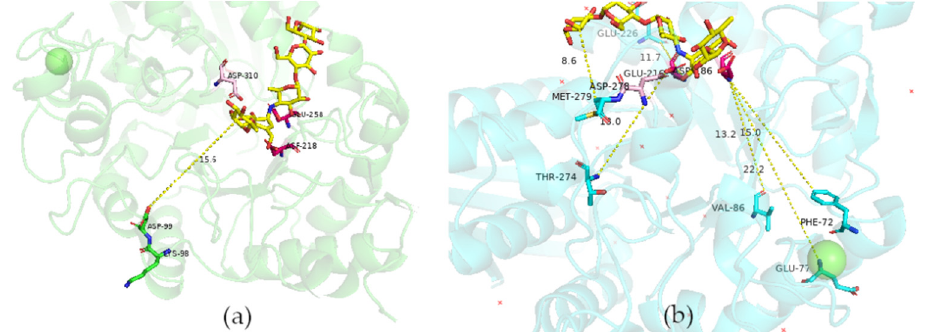
Figure 7. Distances in Angstrom between the mutation sites (green and cyan) and the catalytic residues (red) ( a ) TmAmyA. ( b ) TmGTase. The active center is delimited by the competitive inhibitor acarbose (yellow). In pink is shown the D310 residue that acts as a transition state stabilizer.